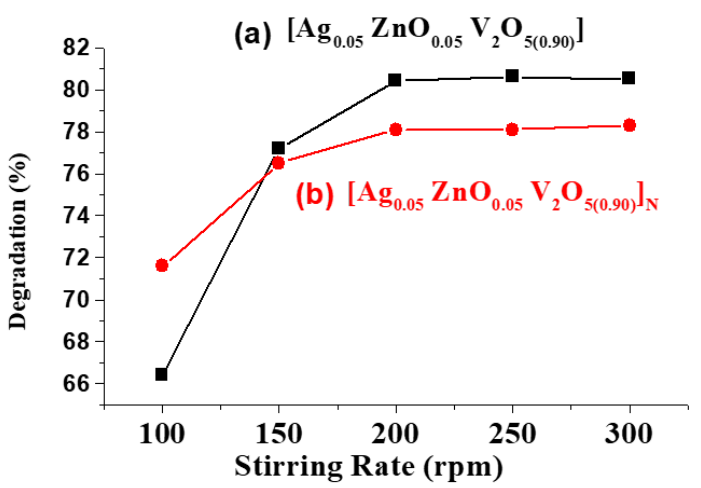
Figure 8. Effect of mass transfer on the photocatalytic degradation of Congo red dye.